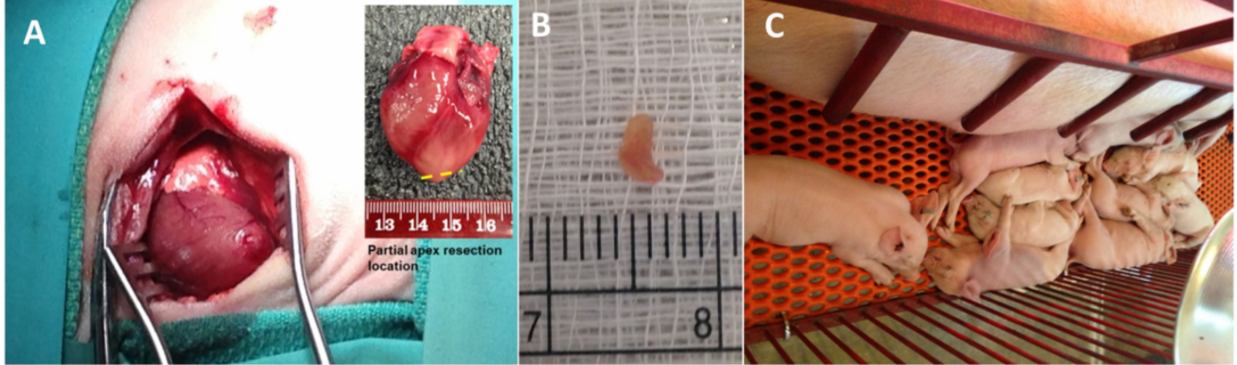
Body Weight at Surgery (lbs)